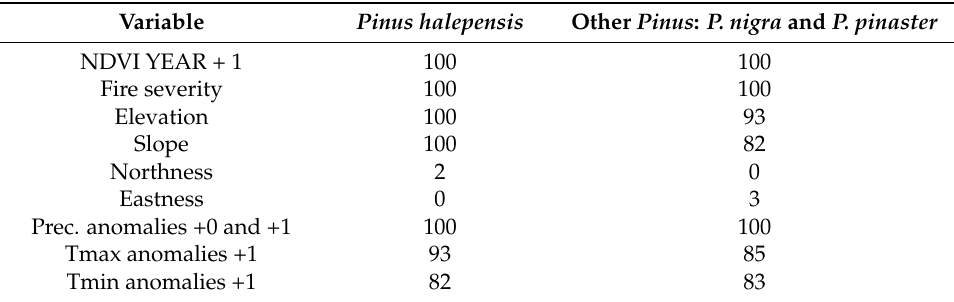
Table 4. Frequency of explanatory variables at the 95% level of significance.